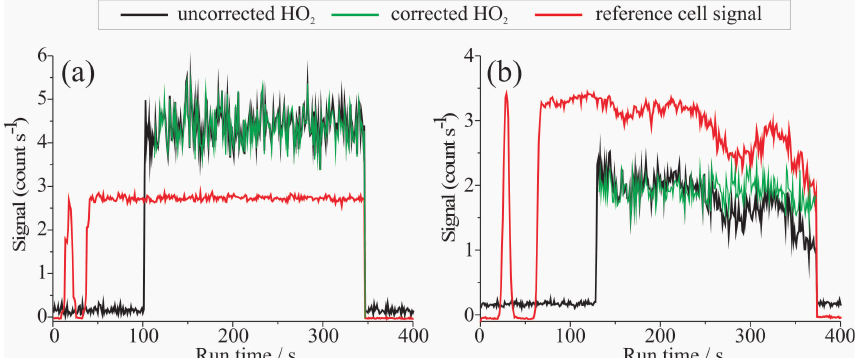
Fig. 1. [OH] (black) and [HO 2 ] (red) recorded at 1 Hz showing influences of pollution from passing boats on 16 June 2009 (left) and the site power generator on 5 September 2009 (right); the green line in the left-hand panel is the 10 s running average of the OH data. The HO 2 data in the right-hand panel have been offset by +2 × 10 8 moleculecm − 3 for clarity.